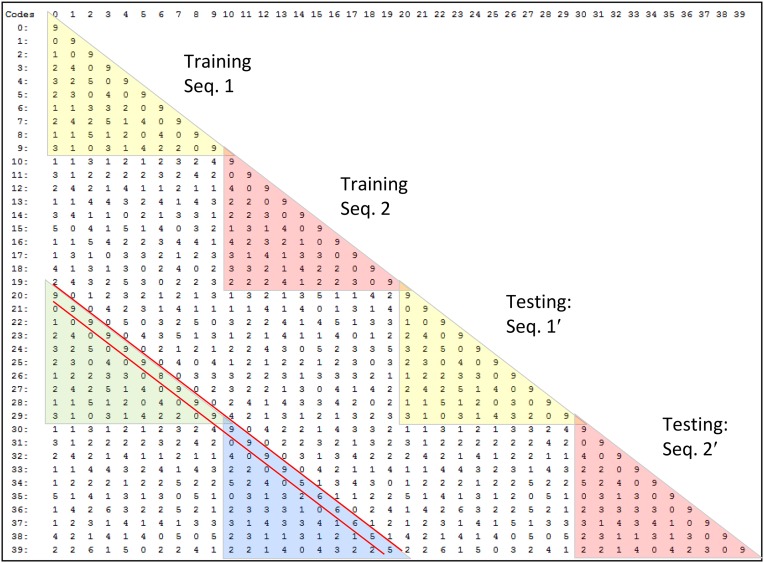
Pair-wise intersections of all L1 codes assigned in one run of the 1-pixel-changed testing condition for the smallest model tested, which had Q = 9, K = 4, and 6336 weights.